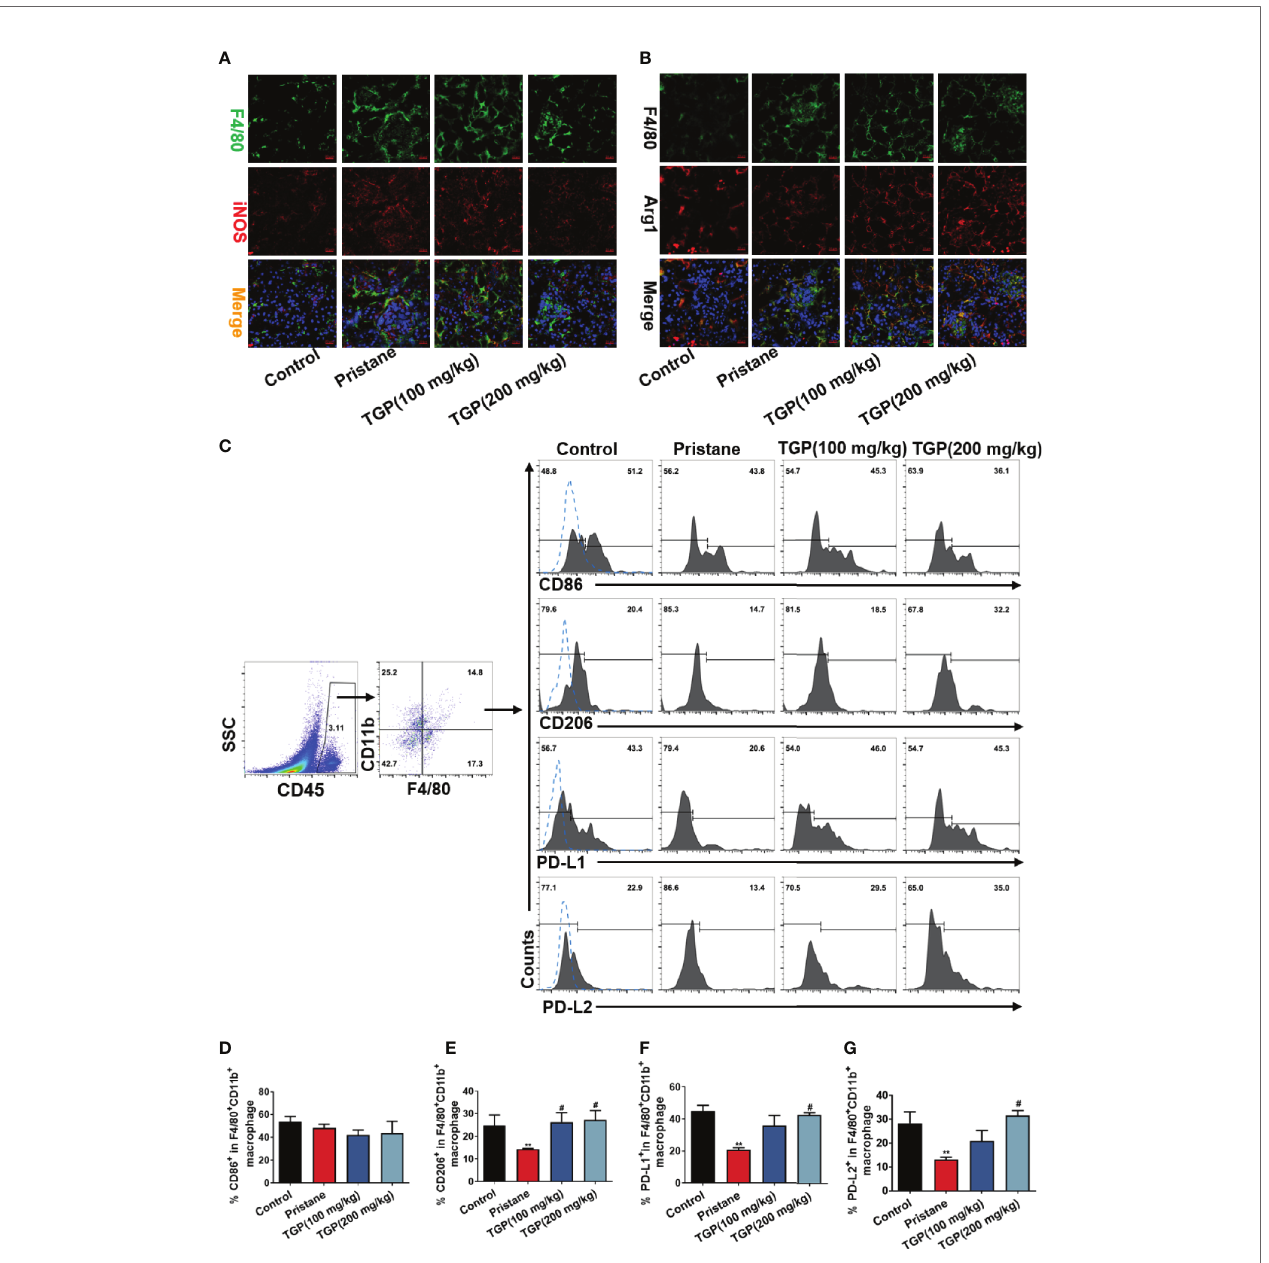
FIGURE 4 | TGP treatment increases renal PD-Ls + macrophage in fi ltration in pristane-induced lupus mice. (A) Immuno fl uorescence double-stainings for F4/80 and iNOS or (B) for F4/80 and Arg1 in the kidney of pristane-induced LN mice 8 weeks after TGP treatment (400×). (C) Kidney in fi ltrating cells were isolated 8 weeks after TGP treatment following pristane injection 24 weeks ago and the total in fi ltrating macrophages were gated on CD45 + F4/80 + CD11b + population. The percentages of kidney in fi ltrating CD86 + (D) , CD206 + (E) , PD-L1 + (F) or PD-L2 + (G) macrophages were determined via fl ow cytometer, as shown by the bar graphs, in which data are presented as means ± SD (n=5-6, **p < 0.01 compared with control, and # p < 0.05 compared with pristane-treated